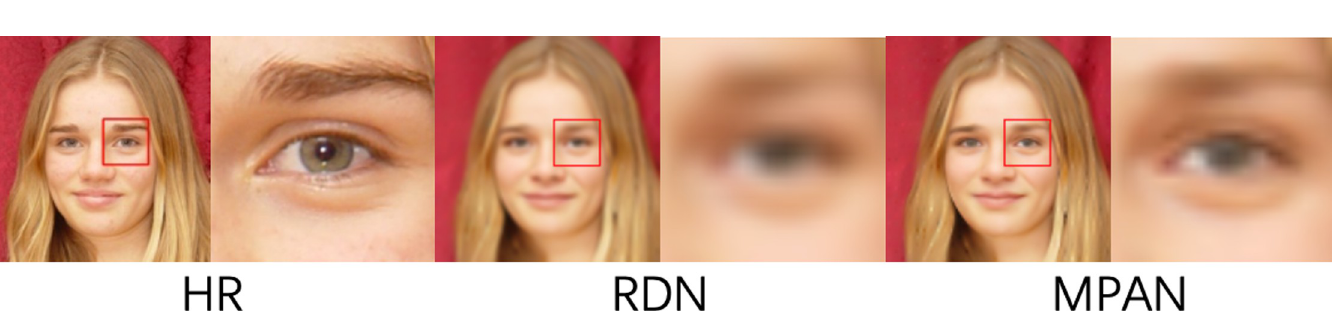
Fig 7. Comparative results of MPAN and RDN for 4X